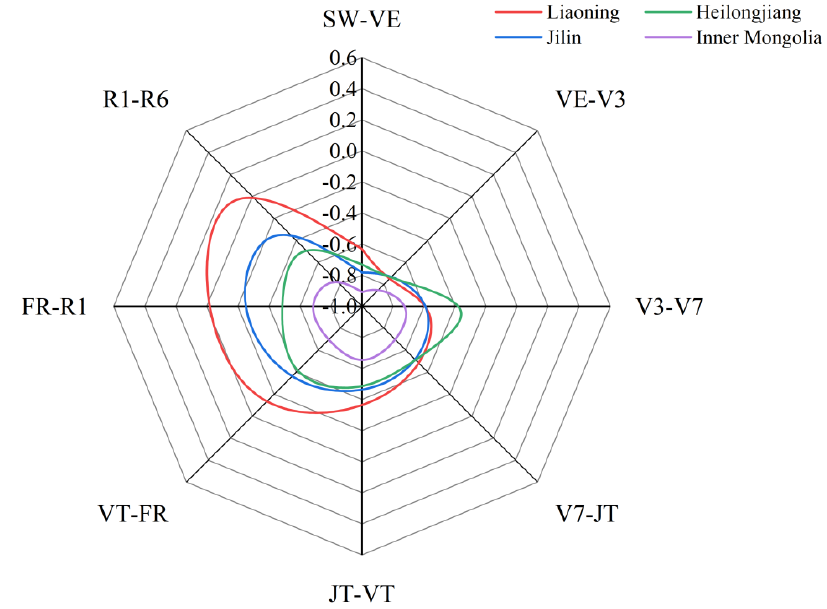
Figure 6. Water surplus/deficit index in different maize growth stages in Northeast China.